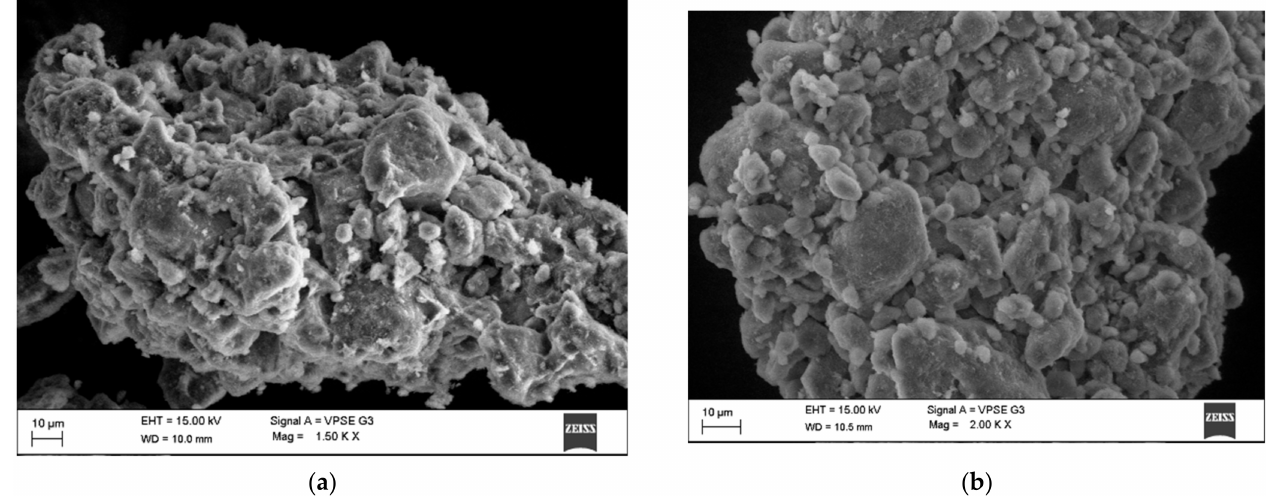
Figure 2. Halloysite nanotube surface characterization pre- and post-adsorption studies. ( a ) HNT pre-adsorption SEM image and ( b ) BG-HNT post-adsorption SEM image.